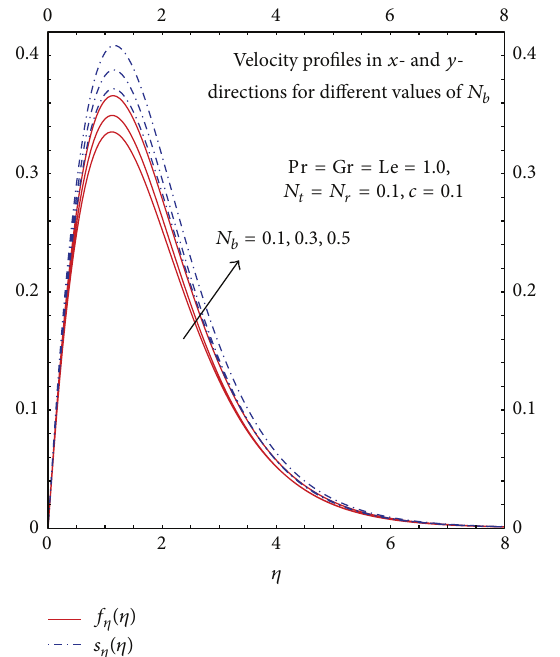
𝜃(𝜂) and 𝜙(𝜂) for different 𝑁 𝑏